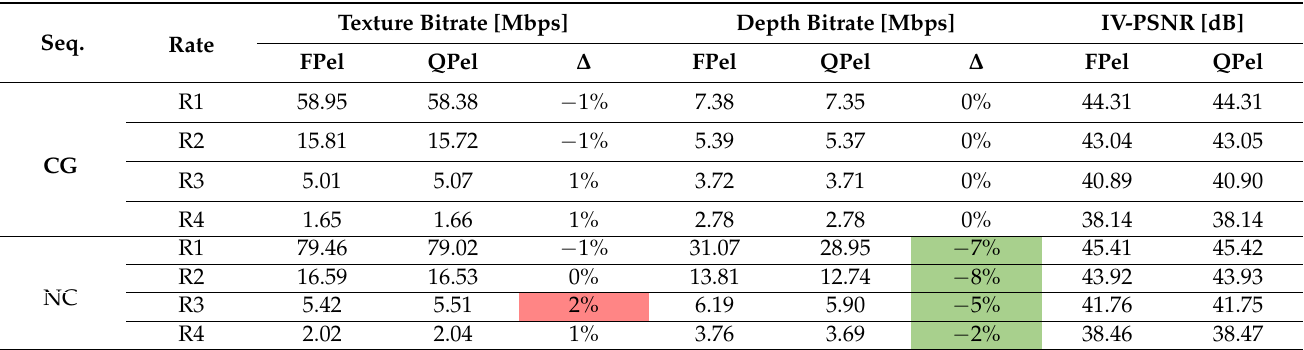
Table 2. Basic SCC vs. SCC with quarter-pel IBV accuracy, bitrate, and quality change for different rate points; bitrate change higher than 2% was highlighted in red (for efficiency loss) or green (for efficiency gain).